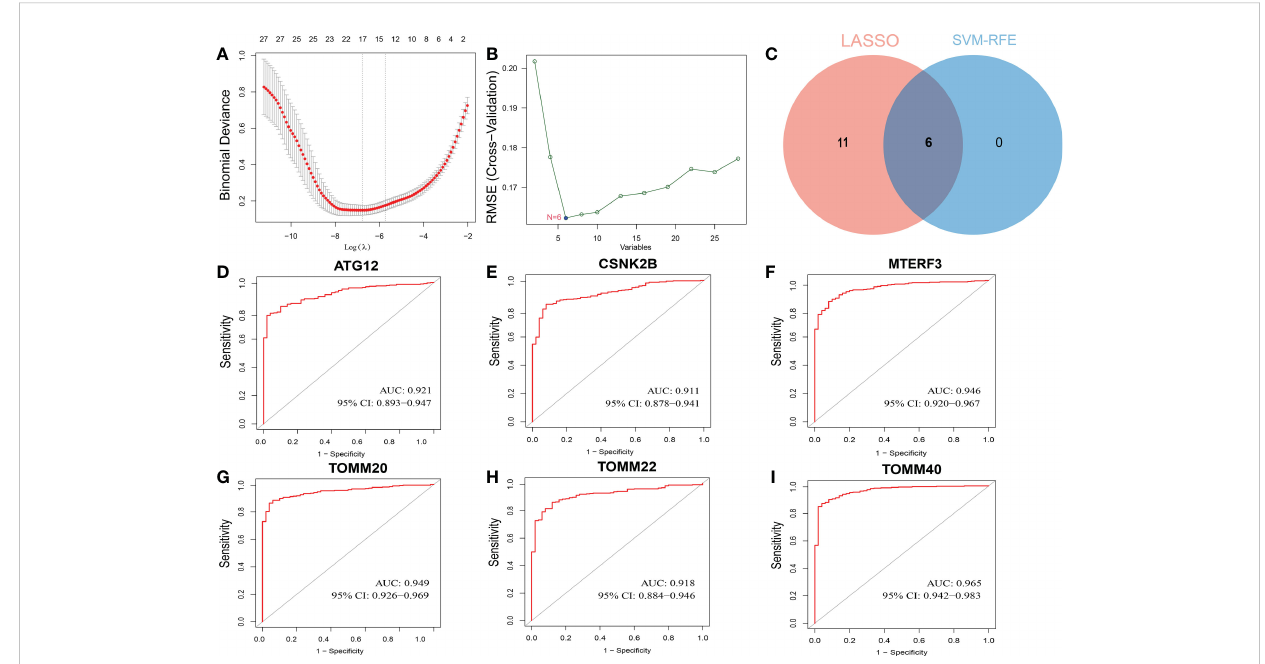
FIGURE 1 Screening process of diagnostic biomarker candidates for HCC diagnosis and several biomarkers were identi fi ed. (A) LASSO regression algorithm. (B) SVM-RFE algorithm. (C) Two ML algorithms take intersection to identify diagnostic feature genes. ROC curves of feature genes in experimental data set. (D) ATG12. (E) CSNK2B. (F) MTERF3. (G) TOMM20. (H) TOMM22. (I)